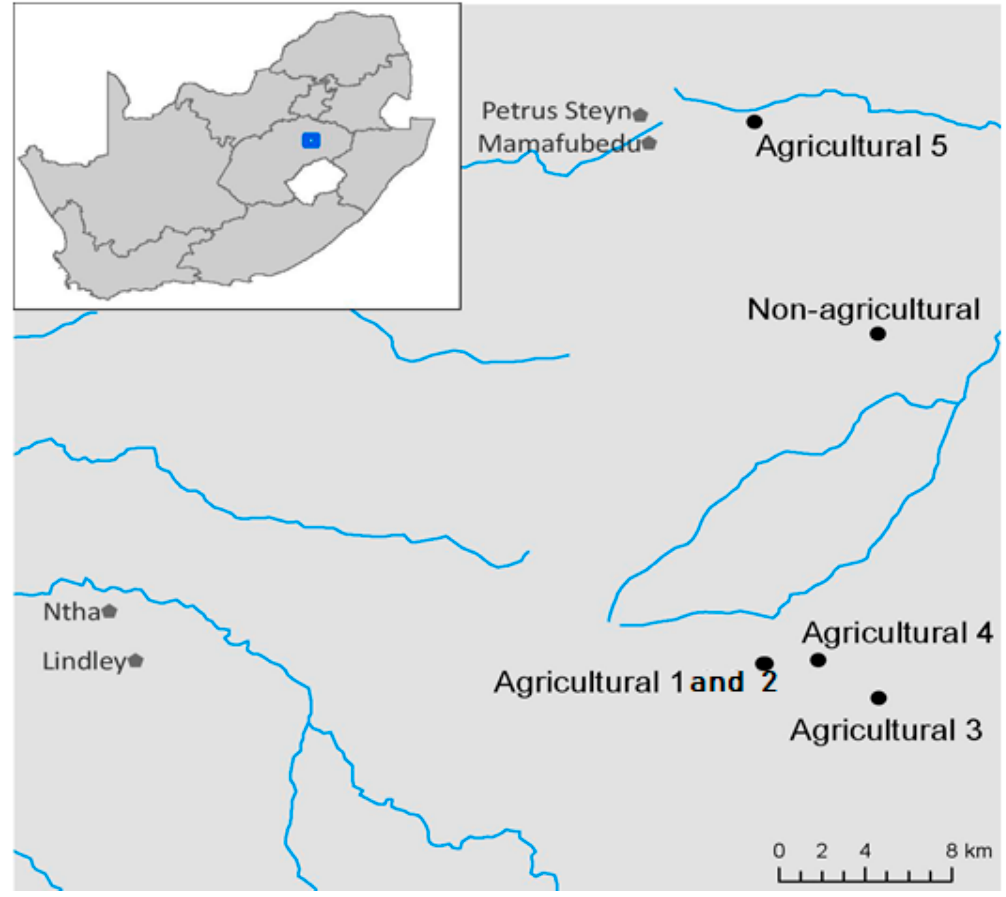
Figure 1. Map of the study area showing the location of sampling areas in the Eastern Free State of South Africa. Black dots indicate the sampling locations. Map courtesy of Dr. Michelle Greve (University of Pretoria).